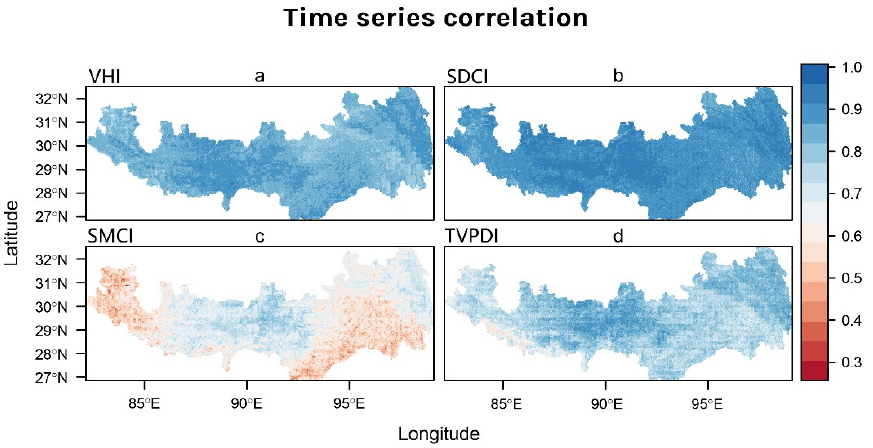
Figure 3. Temporal correlation between TVMPDI and several remote sensing drought indices, including VHI ( a ), SDCI ( b ), SMCI ( c ) and TVPDI ( d ).